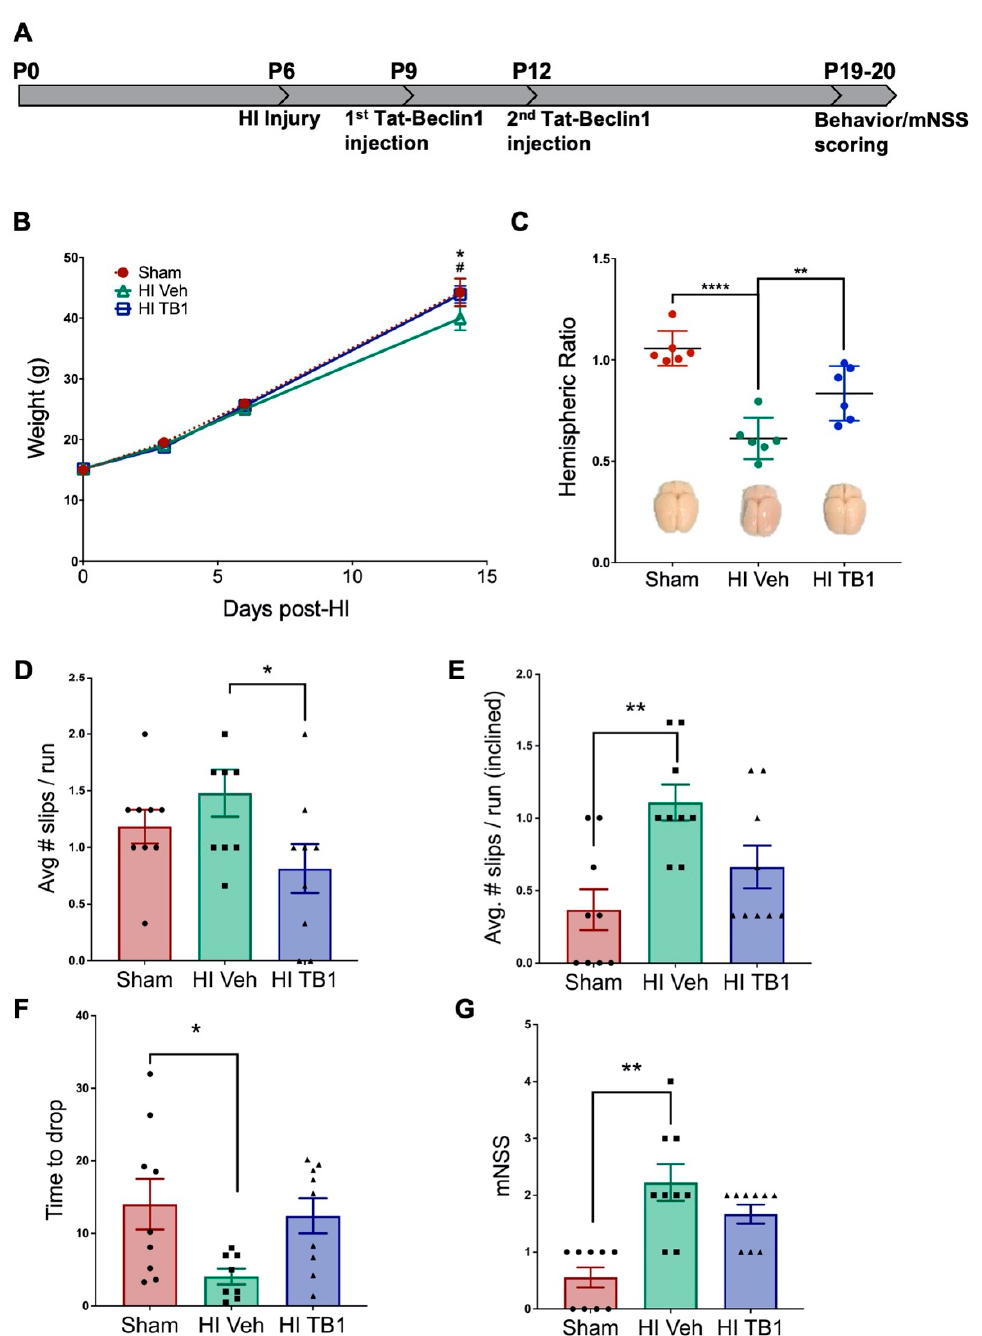
Figure 4. Systemically administered Tat-Beclin1 improved sensorimotor outcomes after HI injury. Two weeks after HI injury at P6, behavioral tests were performed to assess sensorimotor function. ( A ) Outline of the experimental paradigm of HI injury and behavioral testing. Three days after injury on P6, rat pups were injected once with Tat-Beclin1 (15 mg/kg), and again 72 h after the first injection. Sensorimotor testing began 13 days following HI injury. Rats were given a pre-training session 24 h before the start of testing. ( B ) Body mass of Sham-injured, HI-injured with vehicle and Tat-Beclin1 (TB1) administered rat pups tracked for two weeks after HI injury on P6. ( C ) Hemispheric ratio (IL:CL) with representative images of brains following extraction. ( D ) Average slips per run on 2.5 cm-wide balance beam. ( E ) Average slips per run on inclined 2.5 cm-wide balance beam, ( F ) Time to drop (s) for hanging bar, ( G ) mNSS score. n = 9 per group. Data are presented as means ± SEM; * p < 0.05, ** p < 0.001, *** p < 0.0001; # p < 0.05 for vehicle-treated vs. Tat-Beclin1 treated rats using one-way ANOVA followed by Tukey’s multiple comparison